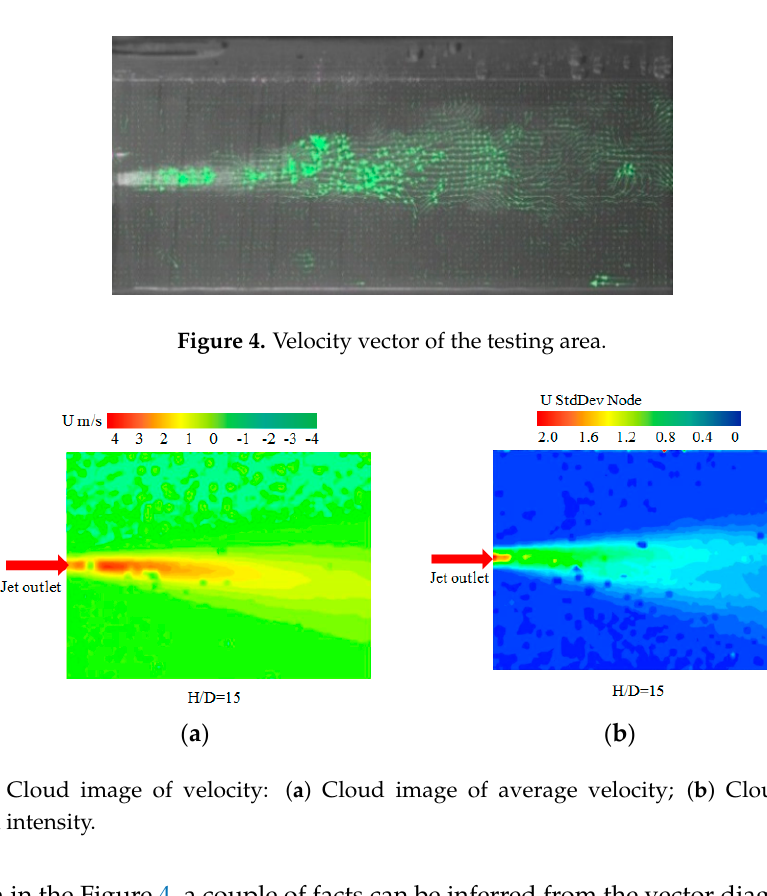
Figure 4. Velocity vector of the testing area.